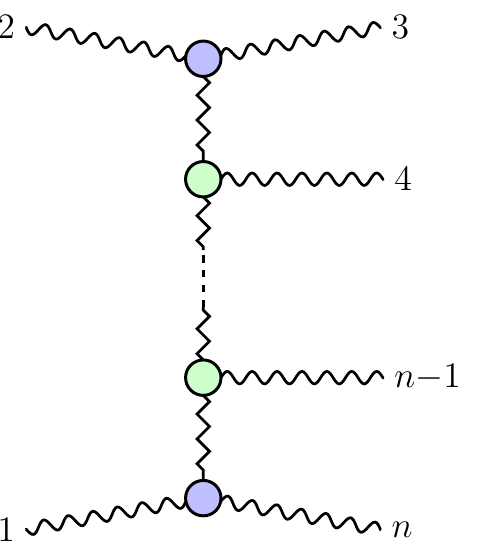
Figure 1 . The factorized form of a tree-level amplitude of gravitons in multi-Regge kinematics.